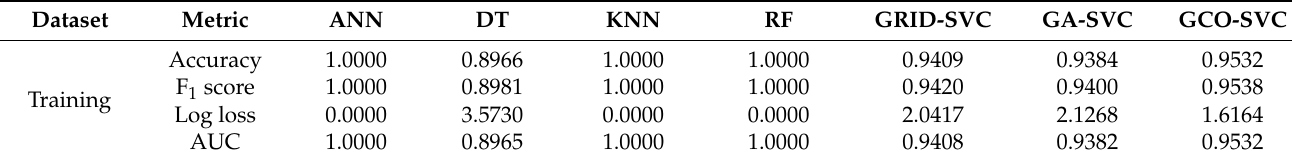
Table 6. Model performance on the training and testing